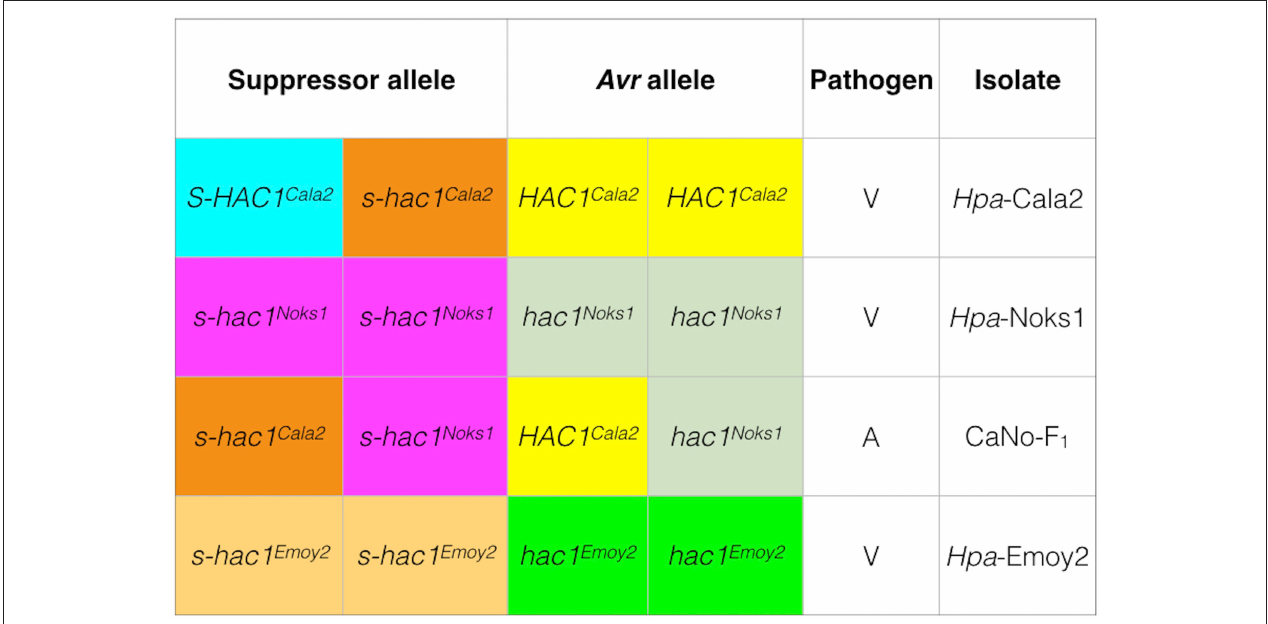
FIGURE 8 | Genotypes of three Hpa isolates at the HAC1 locus. Sequencing and pathology results were used to determine the genotypes of isolates. In Hpa -Cala2, virulence on RMX-A02 results from the combination of an active suppressor ( S-HAC1 Cala2 ) and an active avirulence ( HAC1 Cala2 ) allele. In the presence of an inactive suppressor ( s-hac1 Cala2 ) and an active avirulence ( HAC1 Cala2 ) allele, the interaction results in avirulence. In Hpa -Noks1 and Hpa -Emoy2, the putative avirulence gene is inactive due to mutations, thus both are virulent on RMX-A02.